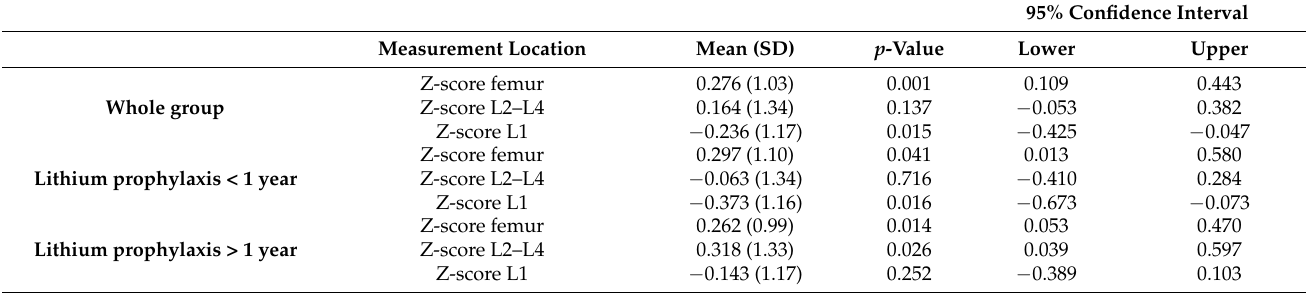
Table 2. Z-scores and bipolar disorder.